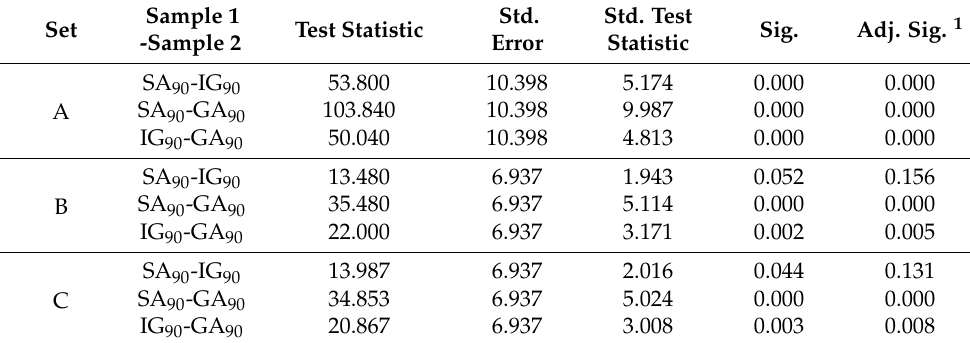
Figure 14. 95% CIs for the mean RDI of algorithms. Table 9. Pairwise comparisons from Kruskal–Wallis tests.